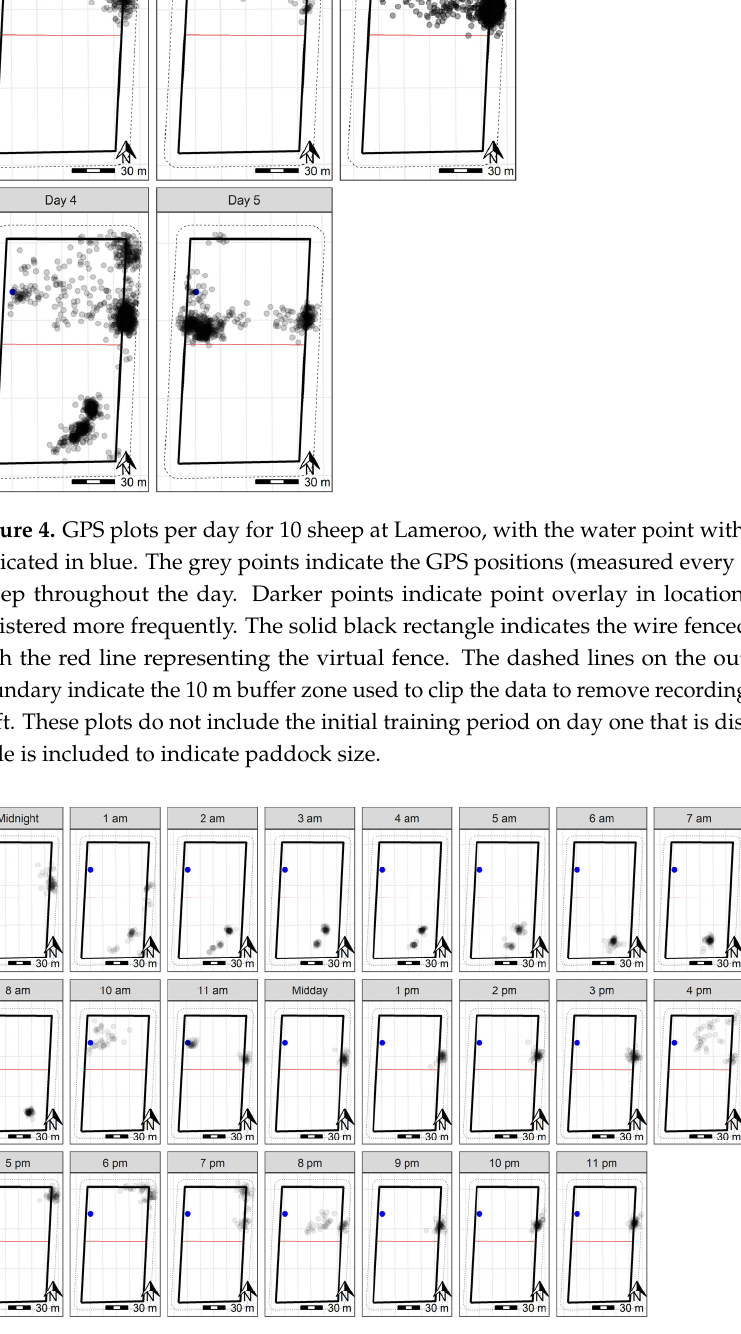
Figure 5. GPS plots across 23 h on day four of the trial for 10 sheep at Lameroo, with the water point